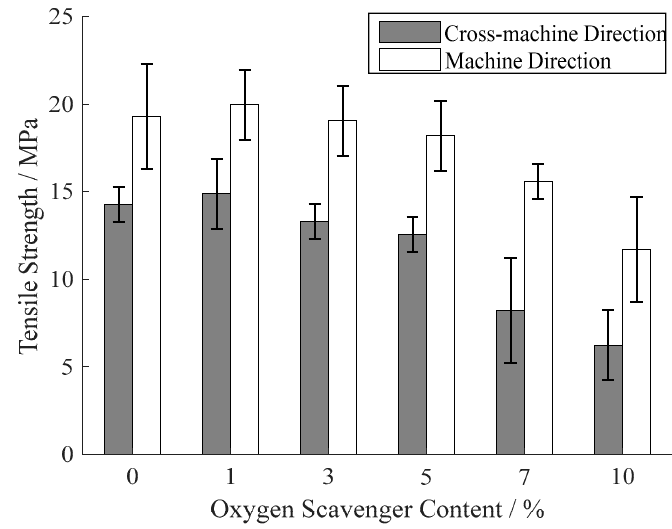
Figure 9. Tensile strength of the prepared films under different oxygen scavenger content.